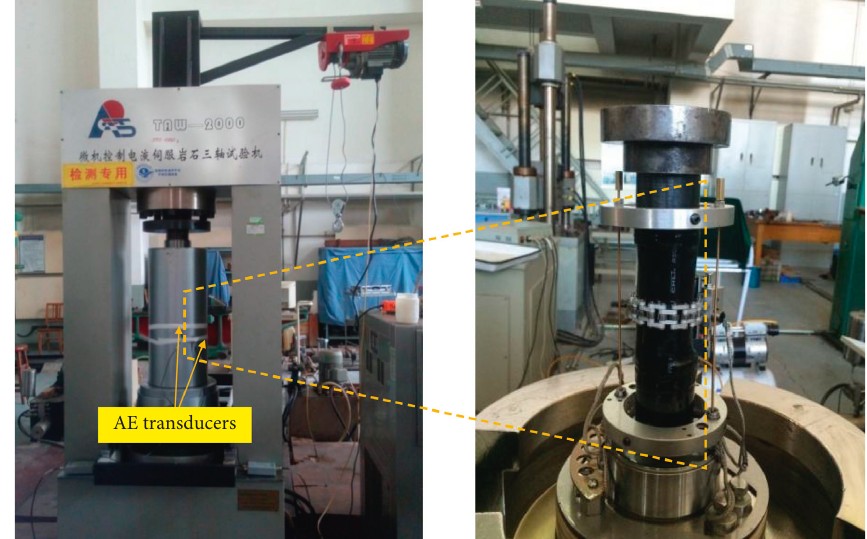
Figure 3: Photo of a triaxial compressive test system equipped with AE